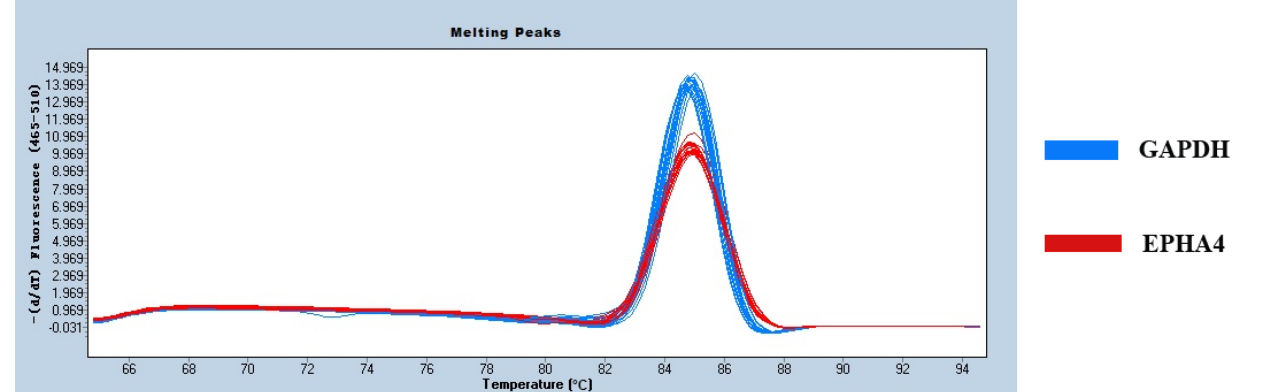
Figure 2. The melting curves of EPHA4 and GAPDH .